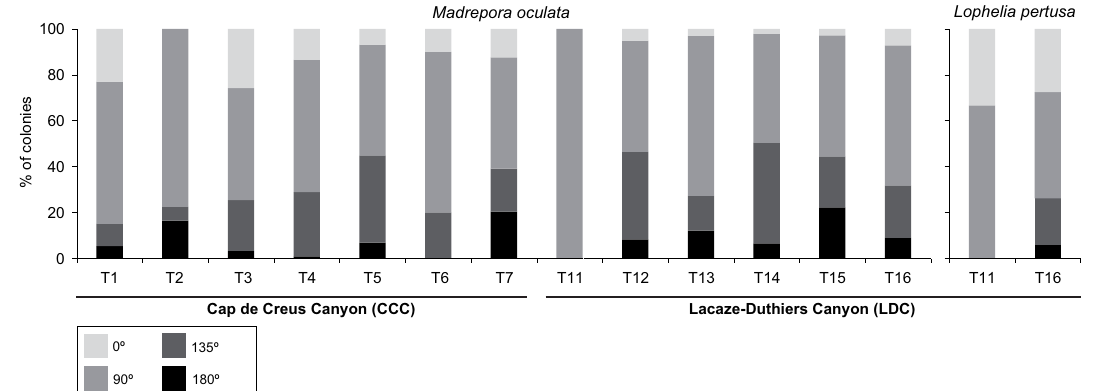
Fig. 6. Orientation of the Madrepora oculata and Lophelia pertusa colonies in the Cap de Creus Canyon (CCC) and the Lacaze-Duthiers Canyon